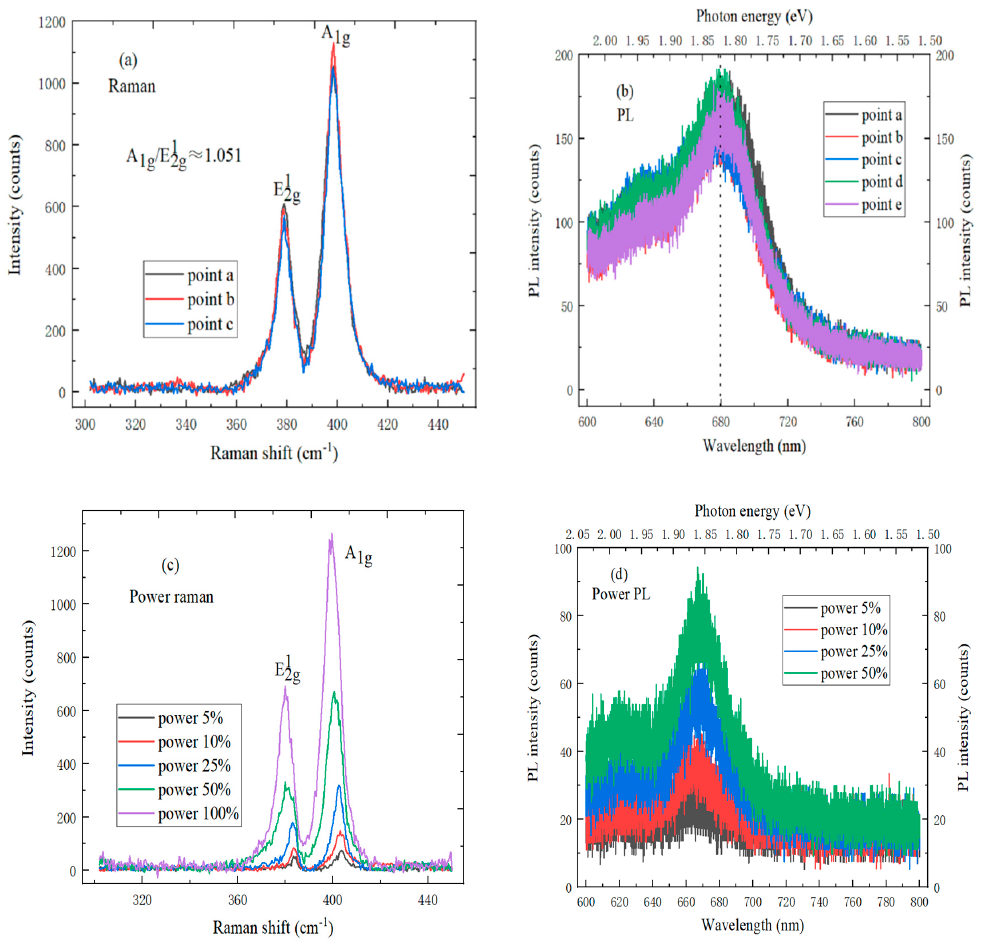
Figure 6. ( a ) Raman spectrum and ( b ) Photoluminescence (PL) spectrum of monolayer MoS 2 on SiO 2 / Si substrate at different points; ( c ) Raman spectrum and ( d ) PL spectrum of monolayer MoS 2 under different laser powers.